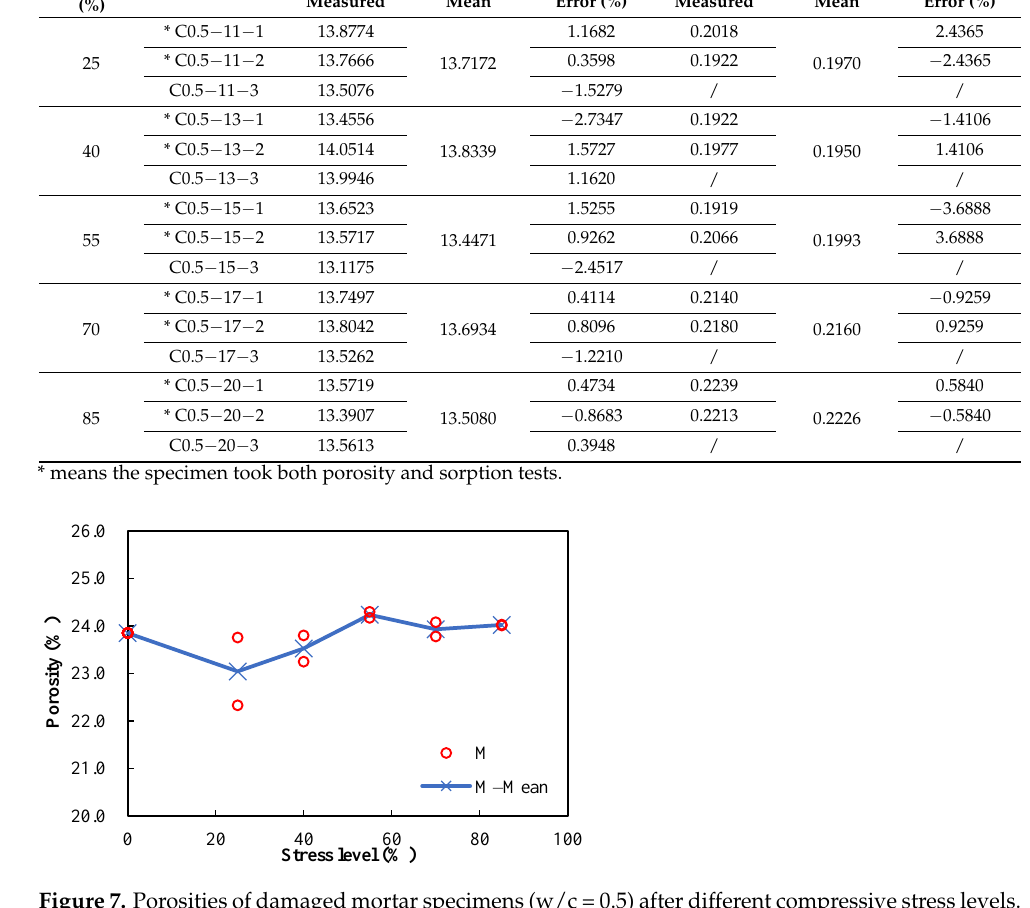
Figure 8. Porosities of damaged concrete specimens (w/c = 0.5) after different compressive stress levels. The measured sorptivities versus the stress levels of damaged mortar and concrete specimens are shown in Figures 9 and 10, respectively. It can be seen that the sorptivities increase with the stress level. Since the direction of the compressive load is parallel to the length and direction of pores, the pores will be radially enlarged and will further develop with the increase in stress level, making the intake of water more convenient. Sorptivity is sensitive to damage, which is proven by its prompt rise with the increase in stress level. Because only marginal difference can be observed between the porosities of damaged and undamaged specimens (Figures 7 and 8), it can be concluded that sorptivity depends on not only porosity but also pore characteristics. It is well known that absorption is one of the major ways for chloride ions and water to penetrate into concrete during a wetting process in the tidal zone, and many studies have shown that reinforced concrete structures in the tidal zone are most likely to suffer chloride-ion-induced corrosion; therefore, dam- age caused by mechanical loads should be considered in the durability design of rein- forced concrete structures in tidal zones.